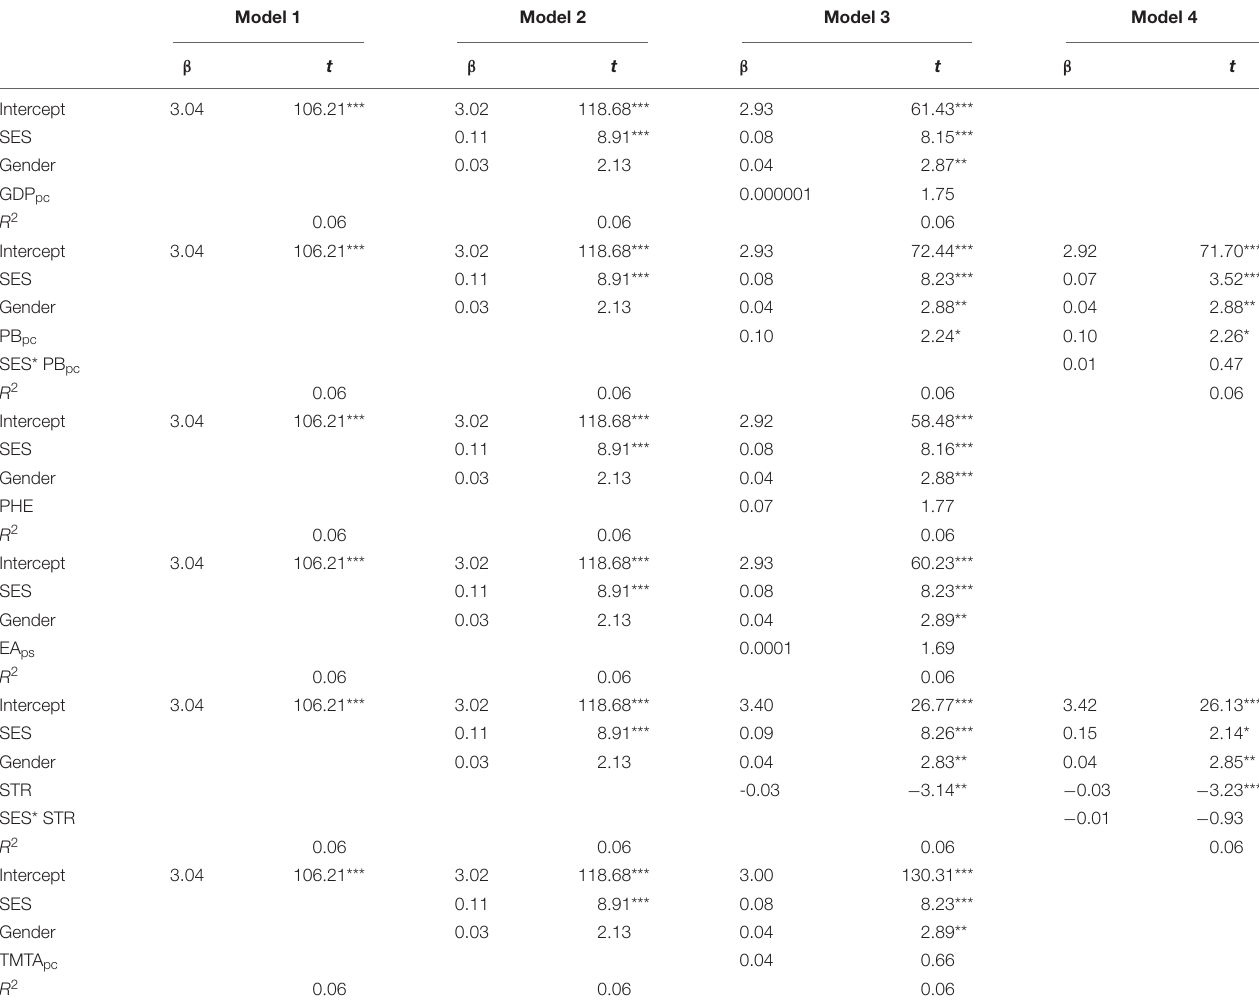
TABLE 3 | The effect of gender, SES and provincial factors on emotional